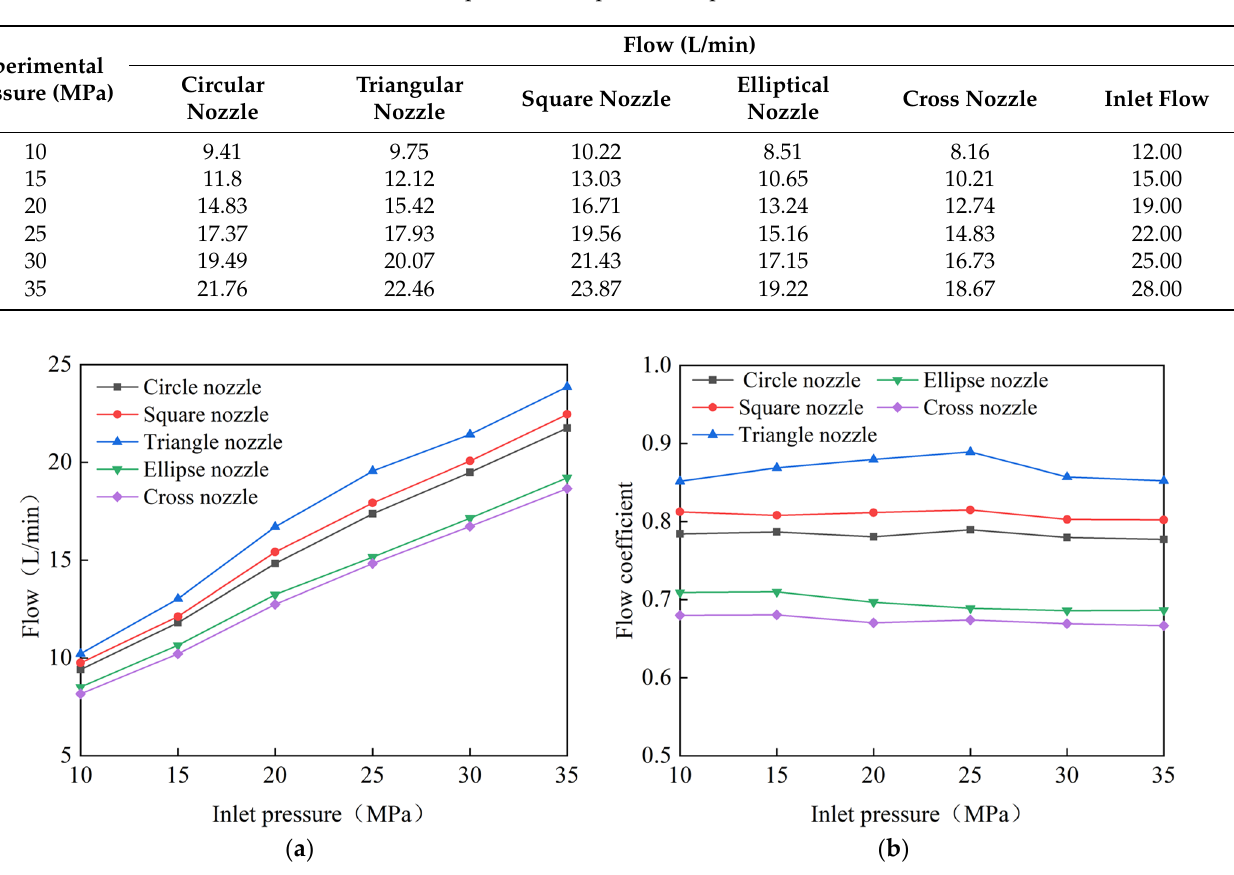
Figure 8. Effect of nozzle shape on flow rate and flow coefficient: ( a ) relationship between nozzle shape and flow under different pressures; ( b ) flow coefficient of nozzle. Table 3. Relationship between experimental pressure and flow of each nozzle.